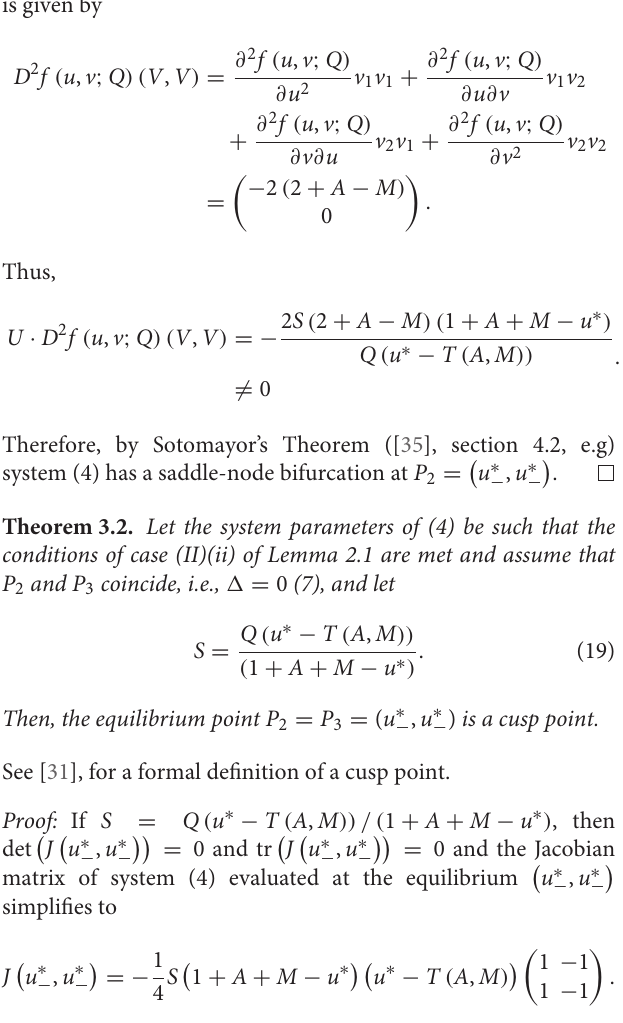
FIGURE 7 | The bifurcation diagram of system (4) for ( A , M ) fixed created with the numerical bifurcation package MATCONT [39]. The curve H represents the Hopf curve, SN 1,2 represents the saddle-node curve, and BT represents the Bogdanov–Takens